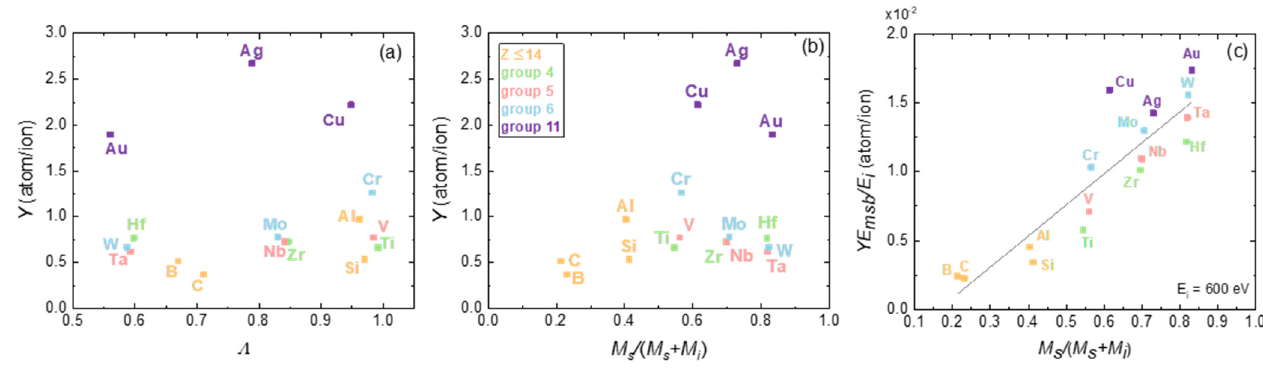
Figure 12. Sputtering yields ( a ) in dependence of the energy transfer factor Λ = 4 M s M i / ( M s + M i ) 2 and ( b ) in dependence of the M s /( M s + M i ), which is a product of the energy transfer factor and the dimensionless factor α . ( c ) Sputtering yield normalized by the E i / E msb ratio in dependence of the M s /( M s + M i ) with a near-linear relation. Sputtering yields were calculated by SRIM using Ar ions with an energy of 600 eV.